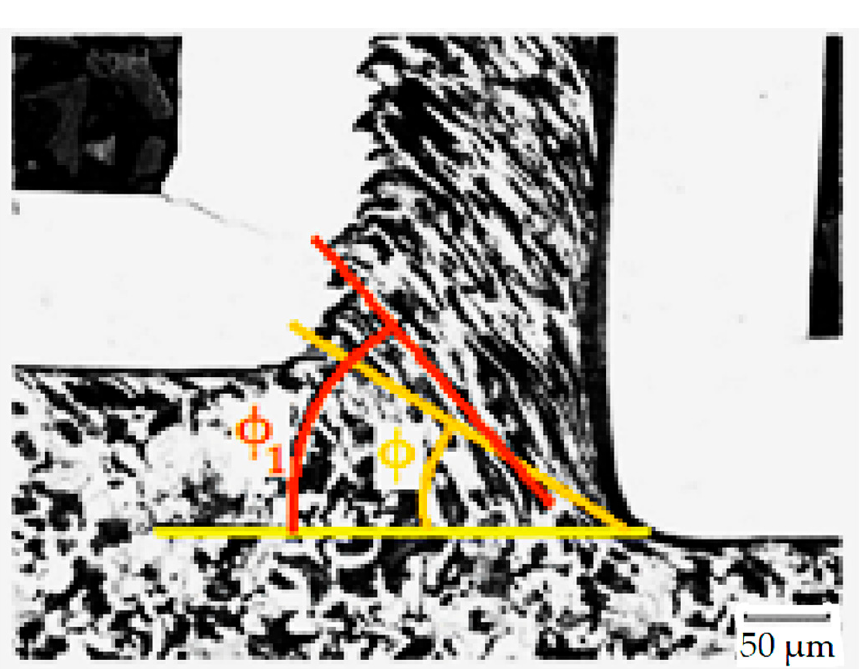
Figure 6. Local plastic deformation in the chip and in the cutting zone of a turned C45 workpiece. Using a quantitative metallography (more specifically, Saltykov stereology methods with oriented test lines), the anisotropic microstructure was decomposed into isotropic- and planar-oriented components. The test lines were placed on a metallographic cut. The lines were parallel and perpendicular to the grain boundaries’ orientation affected by straining: In the primary area, the lines were parallel to the orientation of the texture, the slip plane (pitch angle φ 1 in Figure 5); in the secondary area, the lines were parallel to chip/tool interface, the tool face; in the tertiary area, the lines were parallel to the machined surface. From the specific number (length unit number) of parallel test lines’ intersections with grain boundaries ( P L ) P and perpendicular lines’ intersections ( P L ) O , the planar-oriented part of the specific surface area ( S V ) OR of the grains and the total specific surface area ( S V ) TOT of the grains were calculated. The degree of orientation of the grain boundaries O was calculated as the ratio of ( S V ) OR and ( S V ) TOT from these values. This procedure of measurement is shown in Figure